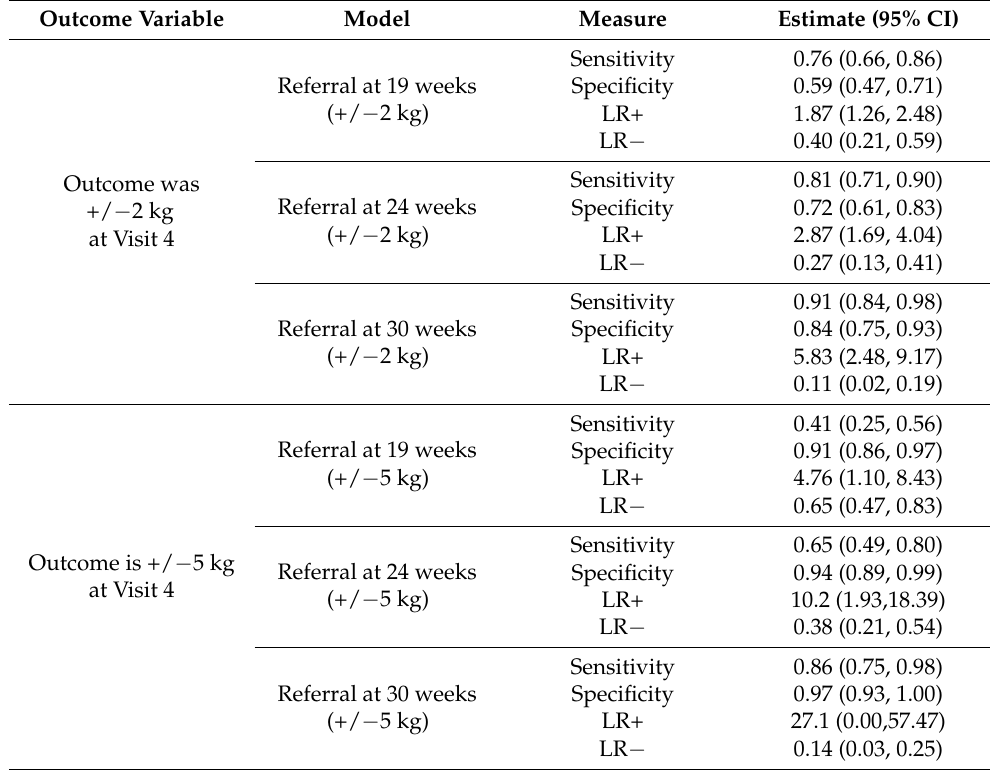
Table 2. Sensitivity, specificity, positive, and negative likelihood ratios for predicting total GWG 36 weeks’